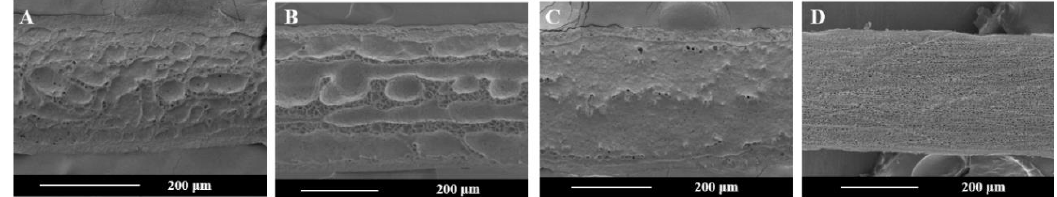
Figure 7. SEM images of fibers fabricated at 3.5 kV, 30 μl/min, and different Z : ( A ) 4 mm, ( B ) 6 mm, ( C ) 8 mm, and ( D ) 10 mm.